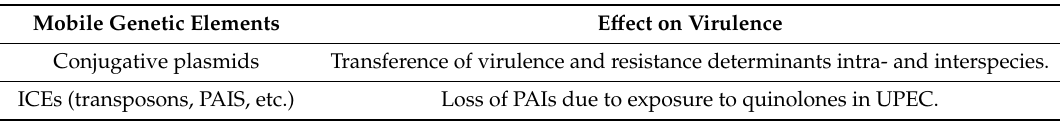
Table 5. Relationships among resistance and virulence through mobile genetic elements. Mobile Genetic Elements Conjugative